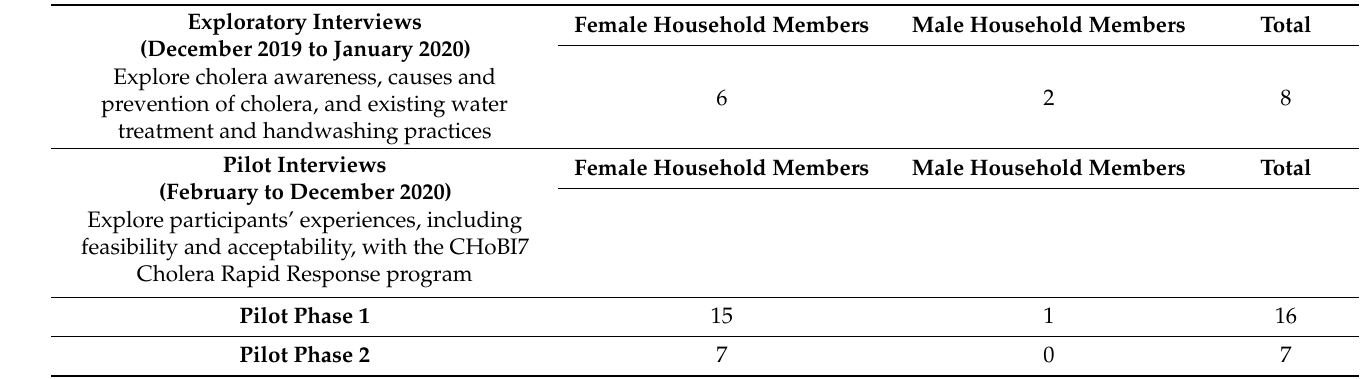
Table 1. Semi-structured interviews conducted with community members residing in cholera